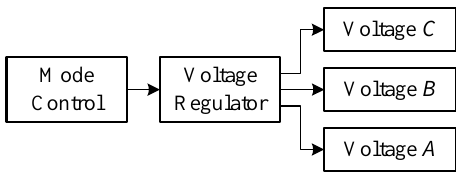
Figure 7. Specific voltage zone distribution layout.